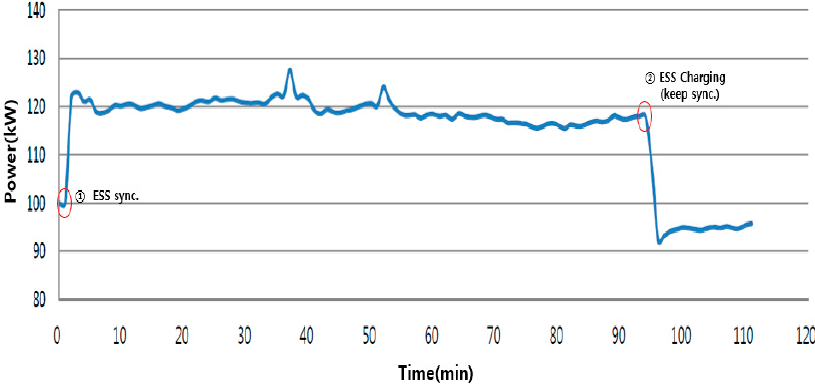
Figure 13. Synchronization and system deviation for load pattern of normal seagoing case 1. Table 6. Synchronization condition in normal seagoing case 1.